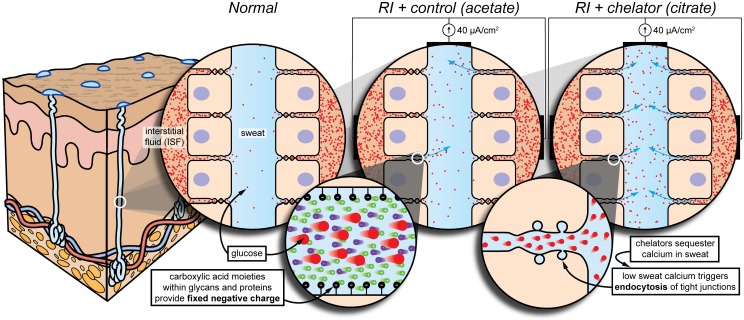
Conceptual model for glucose flux under various conditions: Normal, electroosmosis, and chelation with electroosmosis.Normal. Tight junctions undergo constant and spontaneous remodeling. While this can cause direct aqueous paths to form momentarily, the majority of glucose likely diffuses from ISF to sweat between opening and closing compartments that fluctuate between the tight junctional strands. RI + control (acetate). Electroosmosis (enlarged) is the flow of fluid resulting from an applied electric field in the presence of an electrical double layer. The fixed negative charges needed to establish the double layer are due to the carboxylic acid moieties within glycans and proteins on the cell surface. Electroosmosis brings in ISF through the paracellular pathway. RI + chelator (citrate). Chelation triggers reversible endocytosis of tight junctions (enlarged), producing many more direct aqueous paths, which close upon reintroduction of calcium. Therefore, we expect electroosmosis with chelation to facilitate much higher glucose flux compared to electroosmosis alone. Skin model has been adapted [1].